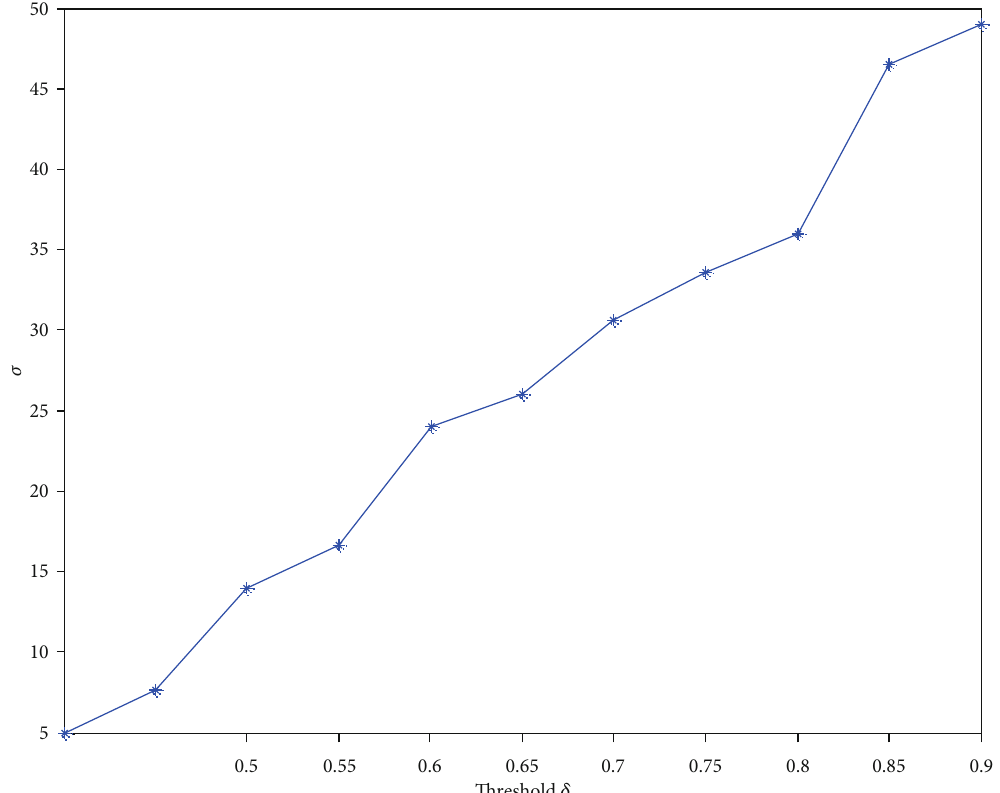
Figure 2: Characteristic diagram of comprehensive index changing with